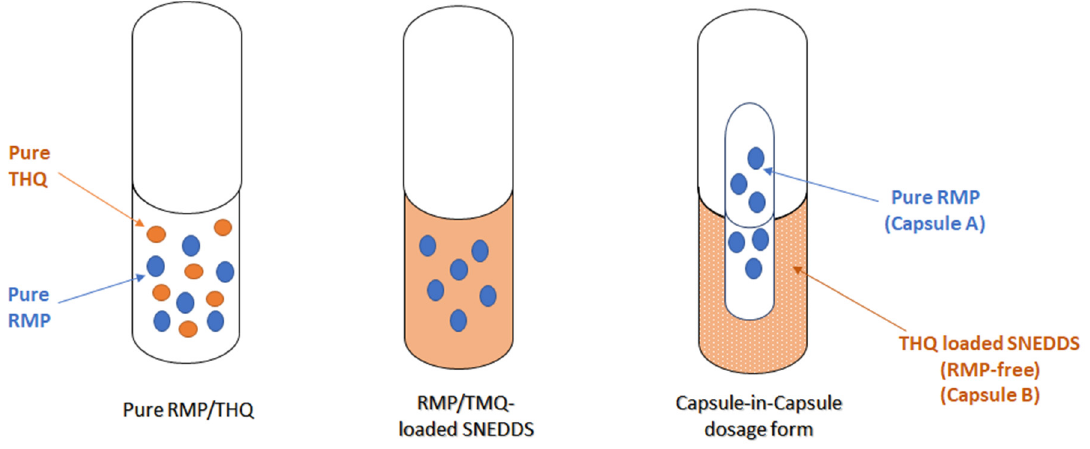
Figure 11. A schematic diagram of RMP/THQ dosage forms.